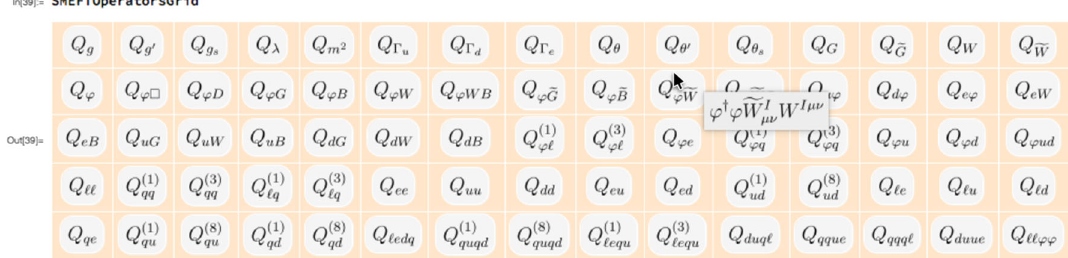
Fig. 4 Result of evaluating SMEFTOperatorsGrid . Positioning the mouse on top of any operator displays its definition, and clicking on it opens a pop-up containing the corresponding chart of Fig. 3. This